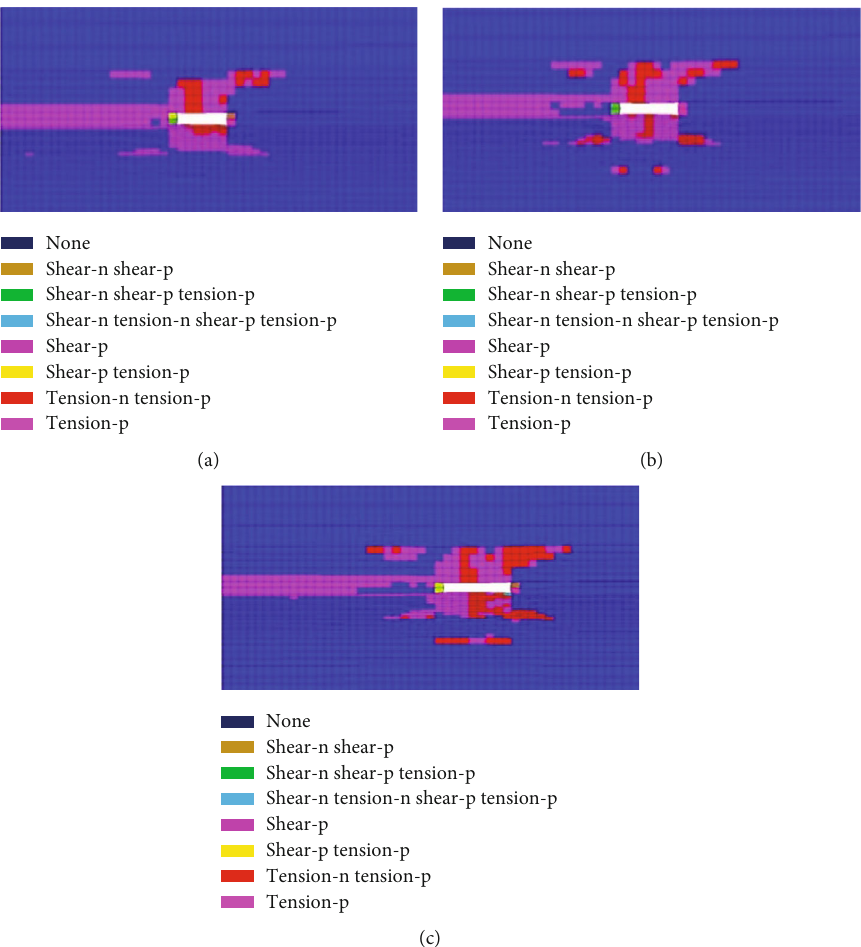
Figure 8: The plastic zone is numerically simulated with di ff erent fi lling steps: (a) 1.2m, (b) 2.4m, and (c)